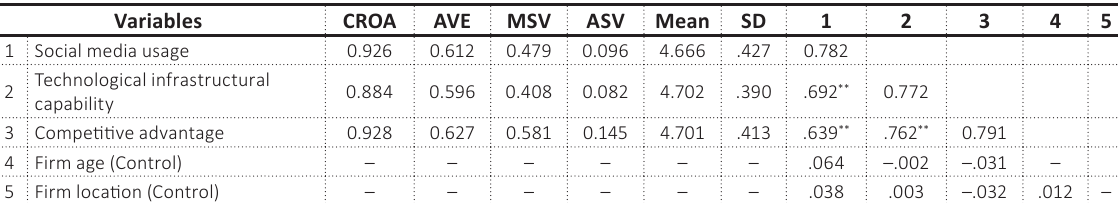
Table 2. Reliability and validity of constructs